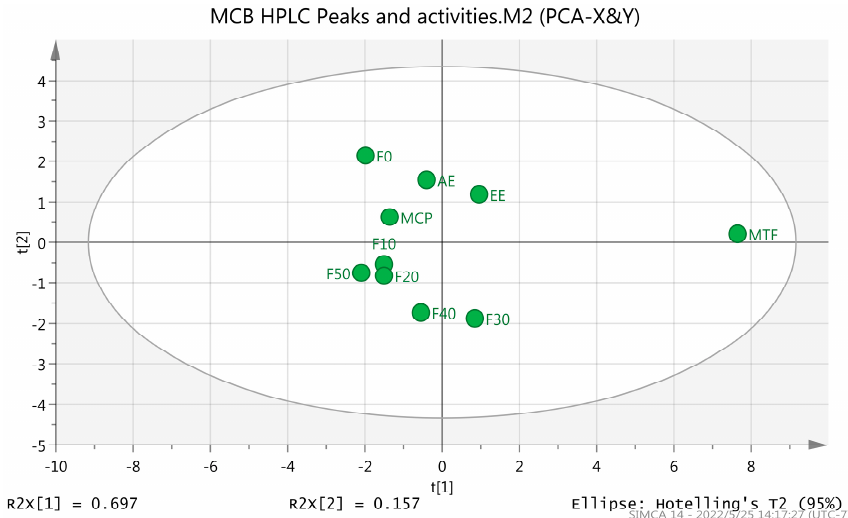
Figure 11. Scores of MCB extracts and fractions (PCA). EE: ethanol extract, AE: aqueous extract, MTF: total flavonoids, MCP: crude polysaccharides, macroporous resin fractional eluent: F0, F10, F20, F30, F40 and F50.